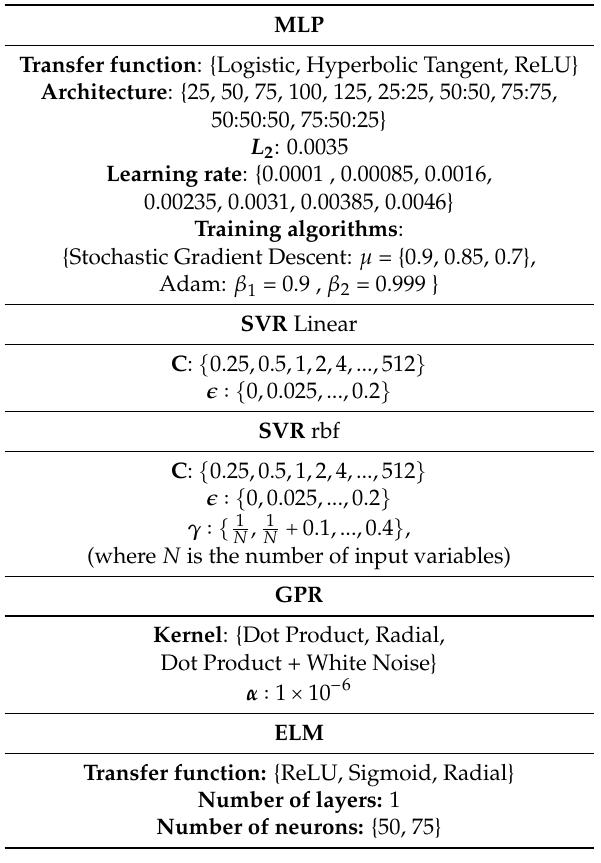
Table 3. Configuration parameters of the ML regressors